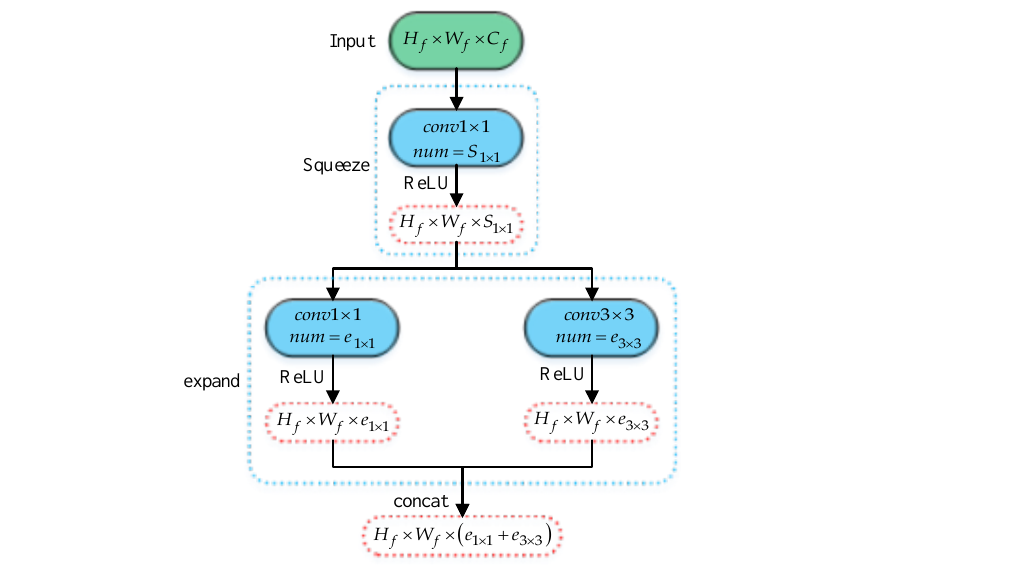
and F m is the deep feature representation of mouth state. The deep representation of the mouth state is defined as the activation value of the hidden unit in the last convolutional layer of the mouth state detection model. H m , W m , and m denote the height, width, and channel number, respectively, of F m